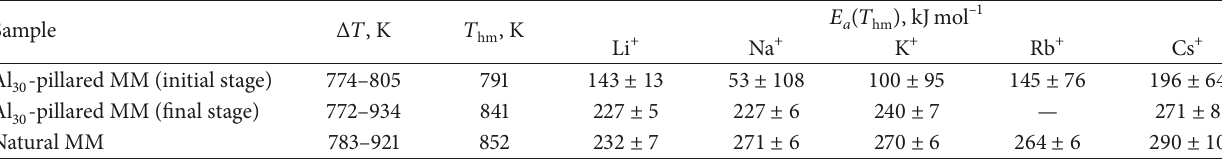
Table 2: Activation energies of thermal ion